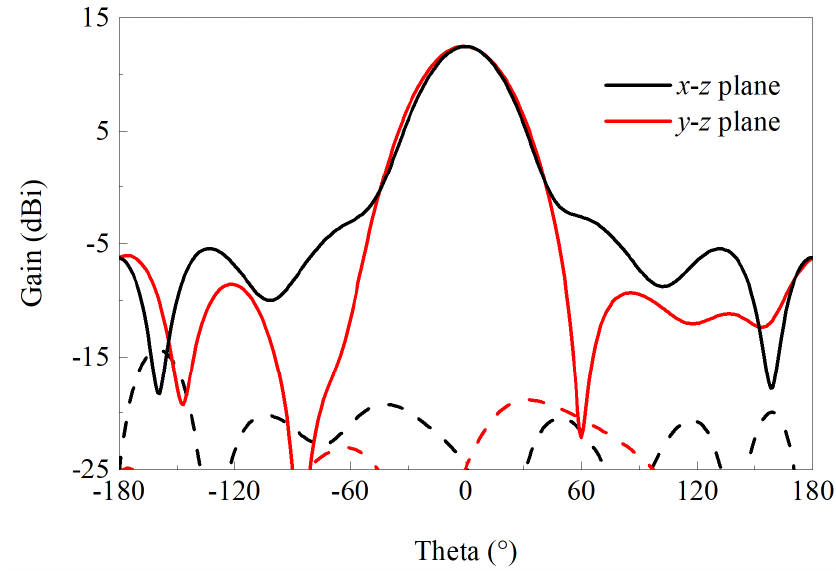
Figure 10. Simulated radiation patterns of the patch array at 5.8 GHz. The solid and dashed lines refer to the co- and cross-polarizations, respectively.